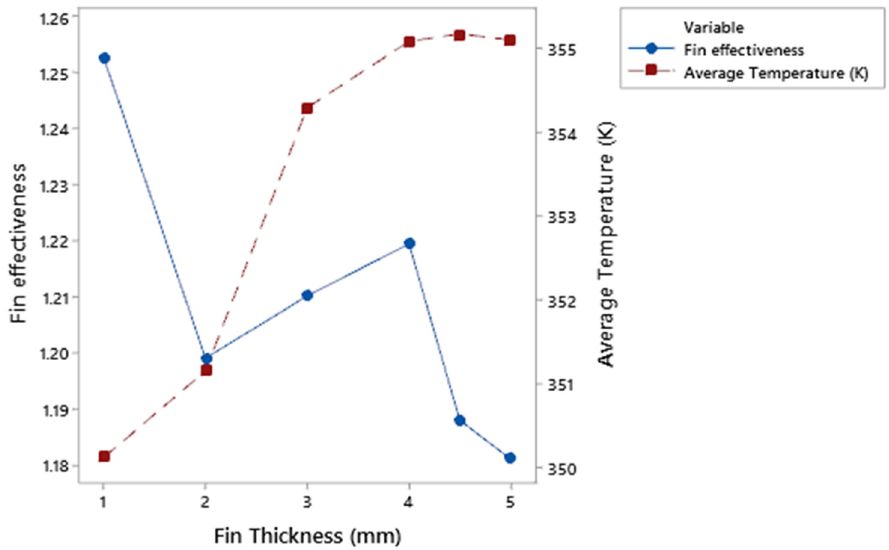
Figure 16. Plot of fin effectiveness vs fin thickness.